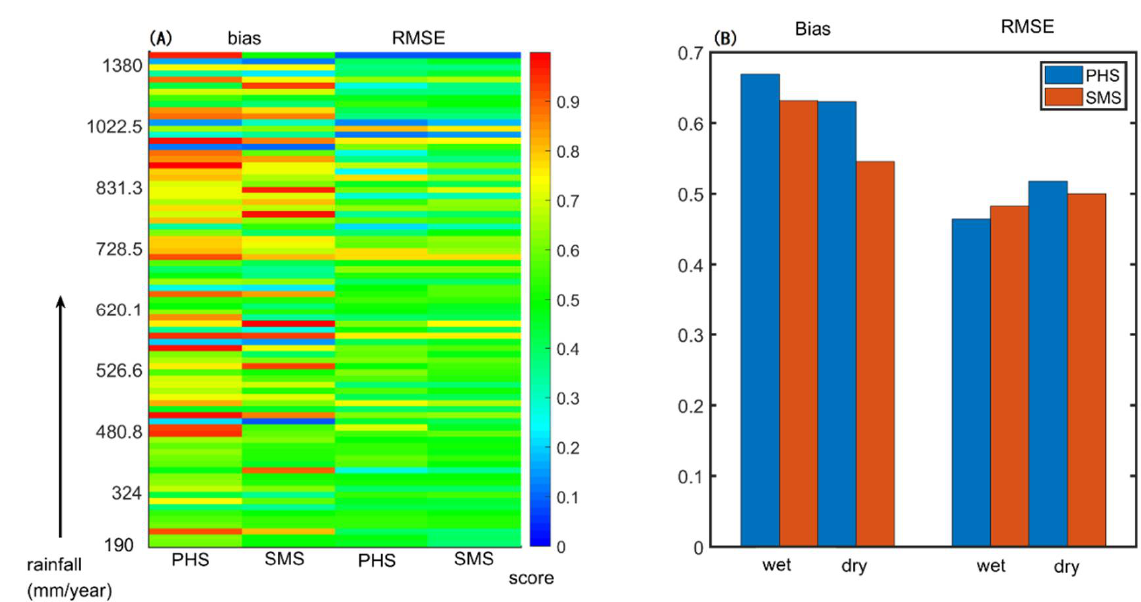
Figure 9. Benchmark results for transpirations. ( A ) Bias score and root mean square error (RMSE) of transpiration modeled by PHS and SMS at 81 sites; ( B ) the score average among sites is grouped by dry sites and wet sites, or by PHS and SMS.